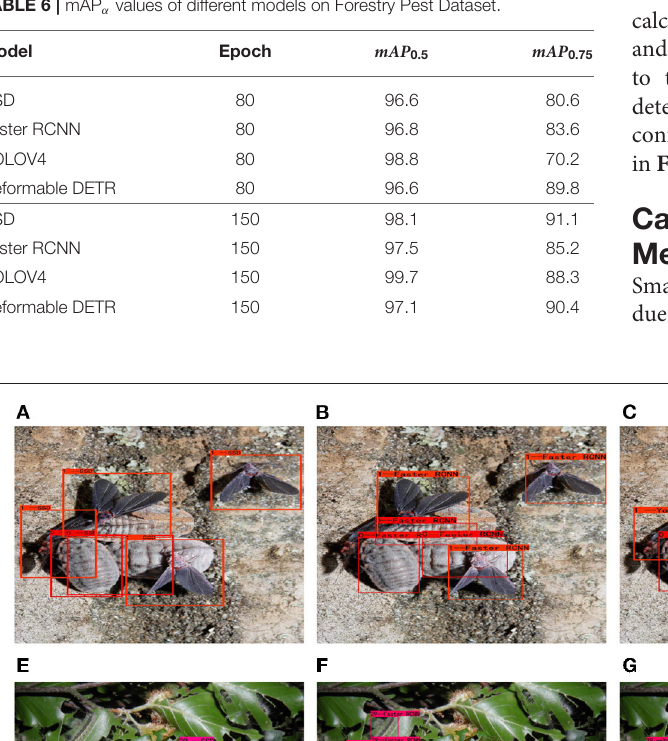
Frontiers in Plant Science |